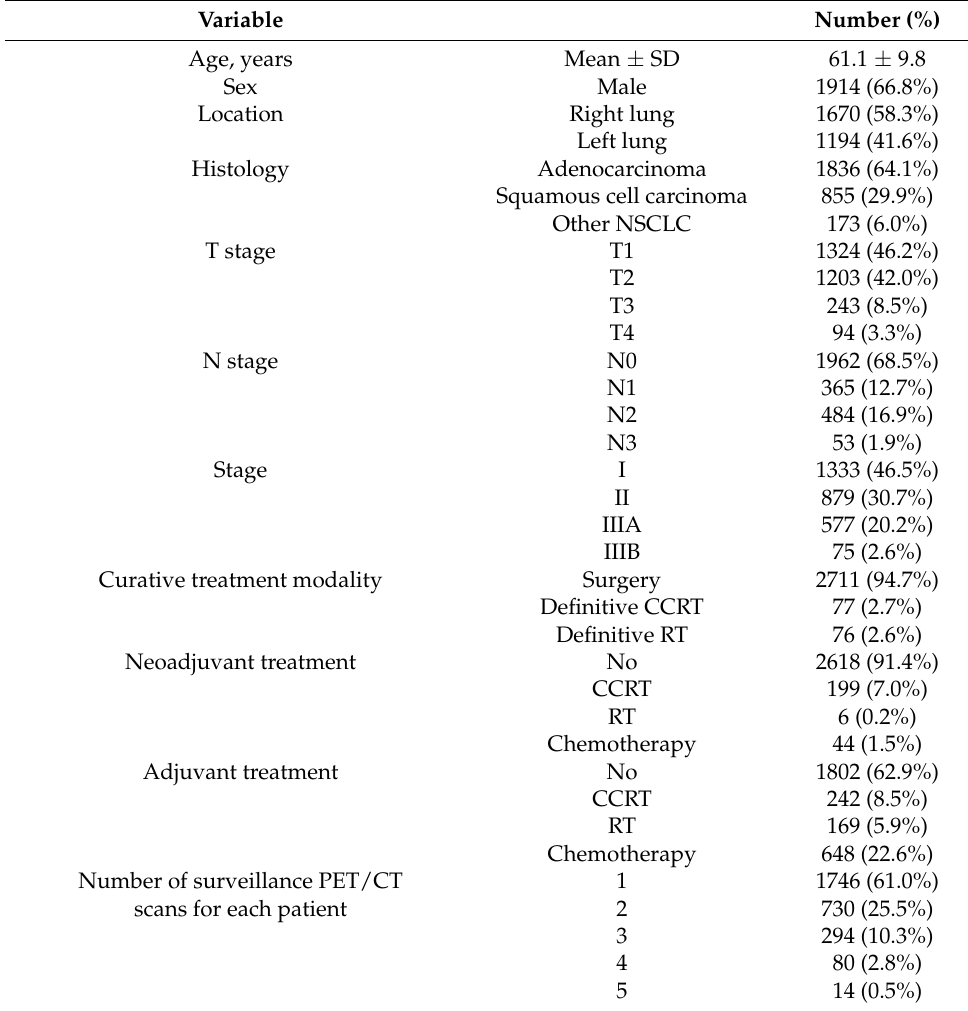
Table 1. Characteristics of 2684 NSCLC patients who underwent 4478 surveillance FDG PET/CT